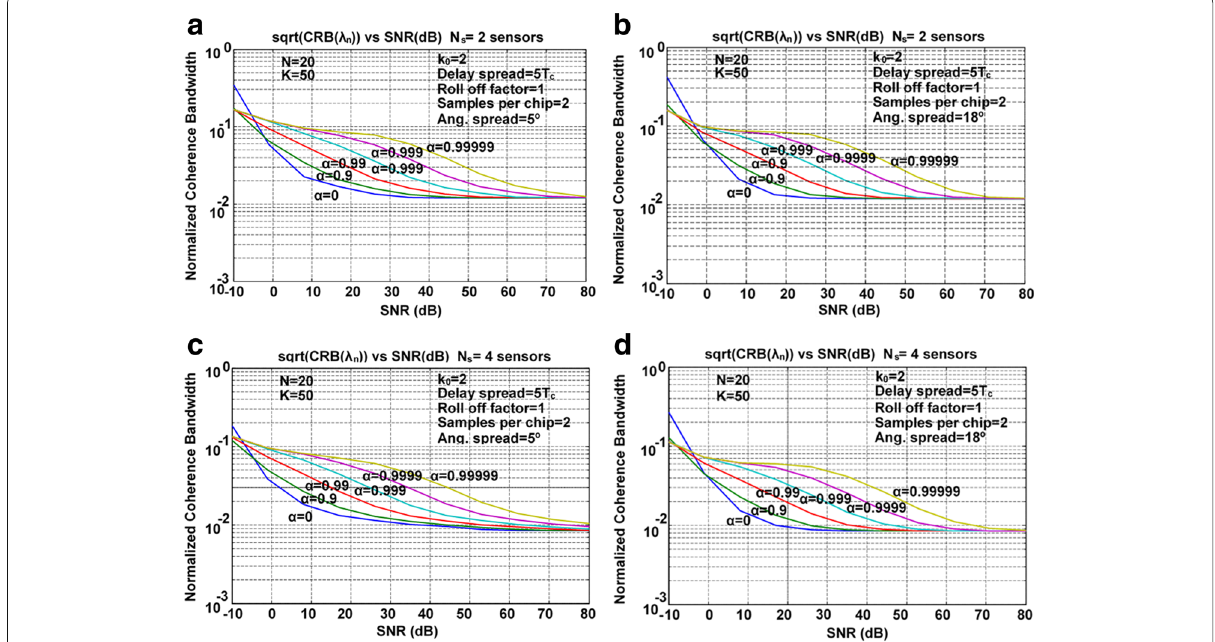
Fig. 3 CRB of the normalized coherence bandwidth λ n in terms of the SNR. Results are provided for different values of the temporal correlation α , different values for the angular delay spread, and different values for the number of sensors K . The number of channel vector estimates K has been set to 50, the delay spread to 5 T c , and the roll-off factor to one. a Top left: angular spread set to 5° and two sensors. b Top right: angular spread set to 18° and two sensors. c Bottom left: angular spread set to 5° and four sensors. d Bottom right: angular spread set to 18° and four